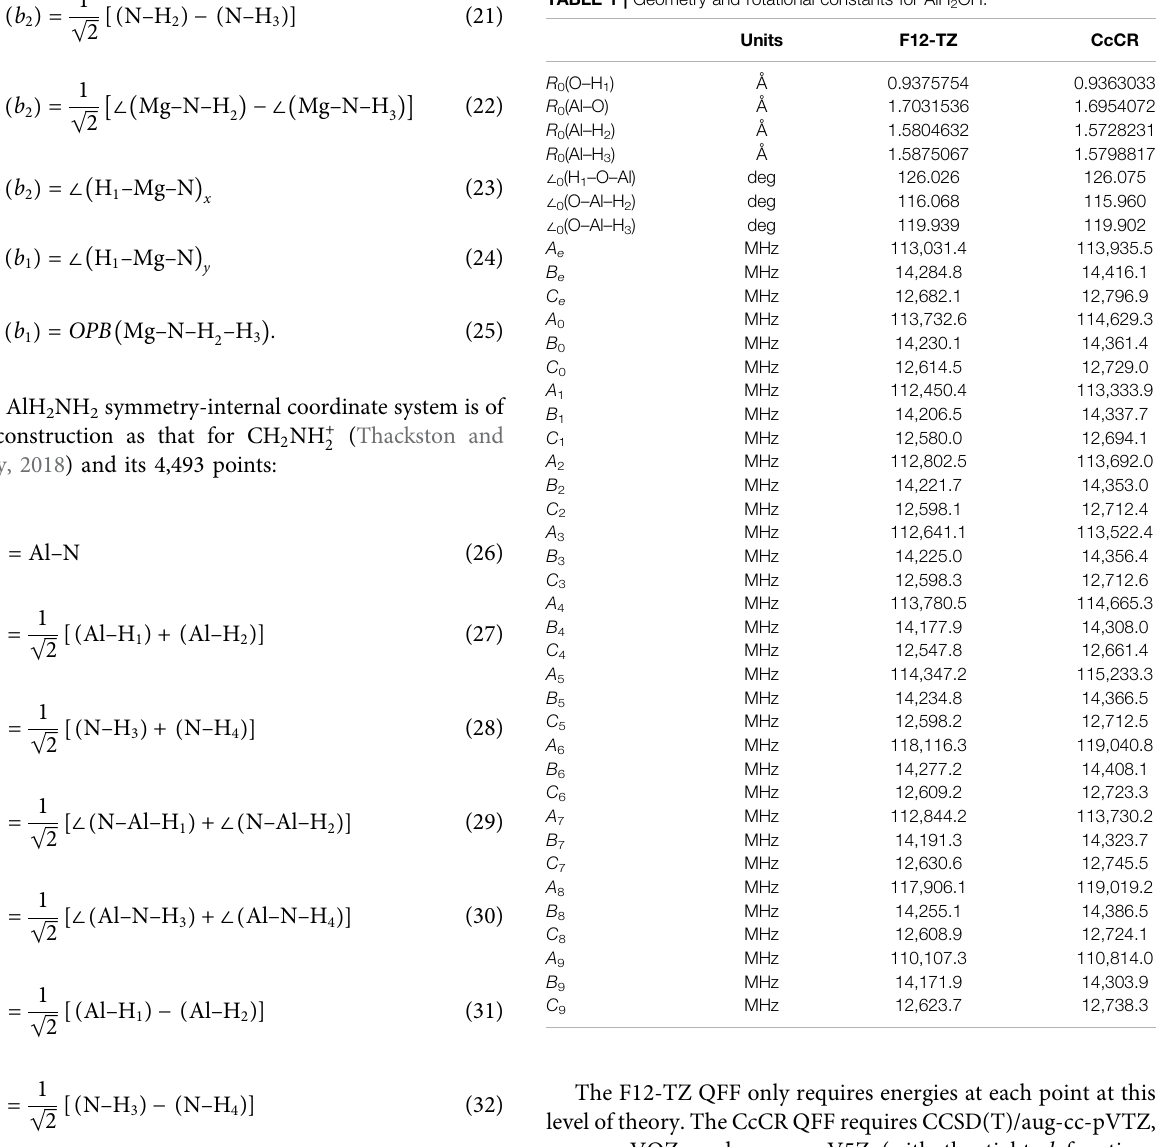
TABLE 1 | Geometry and rotational constants for AlH 2